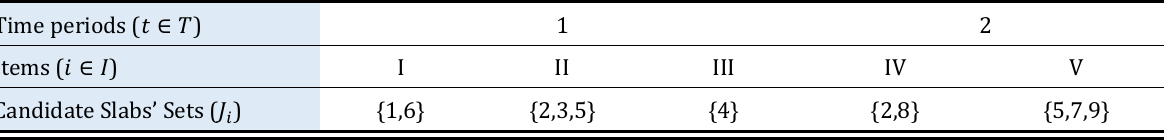
Fig. 2. An example of multi-period